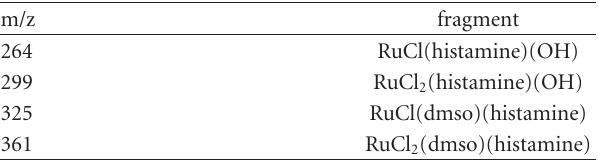
Table 4: Main peaks in the ESI-MS spectrum of compound 1b and respective